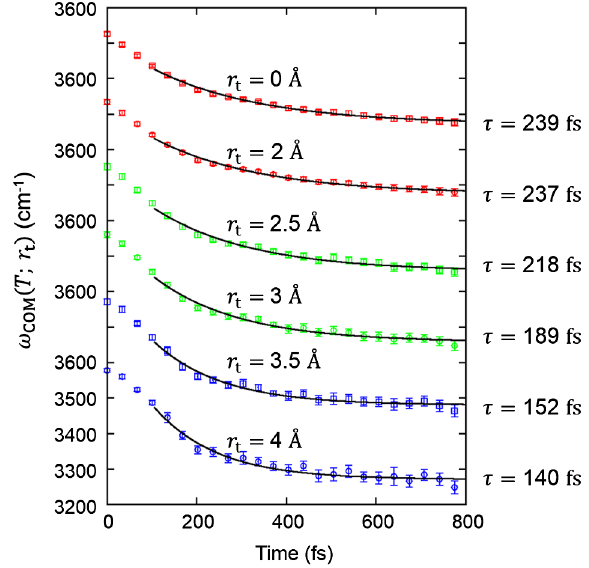
FIG. 2. Spectral diffusion of the O-H stretch vibration, which slows down as delocalization is decreased. We show time traces ð T ; r Þ with various truncation radii of the COM frequency ω COM t r . Mono-exponential fits (solid black lines) demonstrate about a t twofold slow-down of the spectral diffusion as the delocalization → 0 of vibrational energy is progressively switched off ( r t